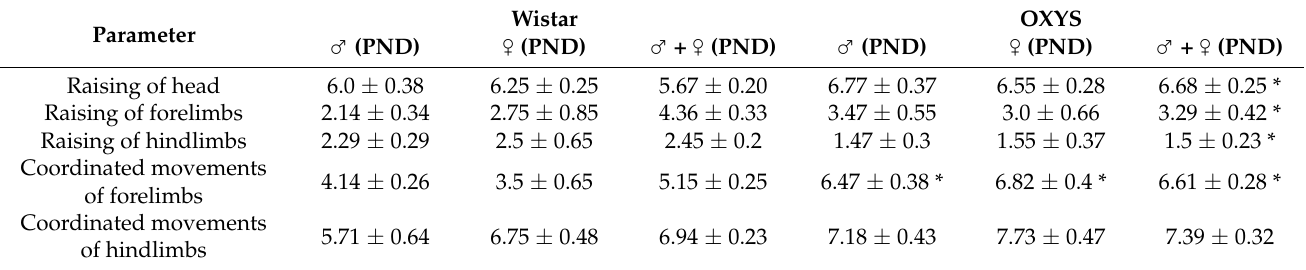
Table 3. Development of the quadruped stance and motion